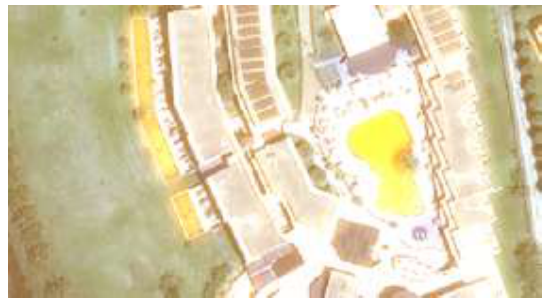
Figure 4. WorldView image of “Scene 2” at spatial resolution 30cm/pixel, after thirteeen years have passed from the QuickBird image of Figure 3.